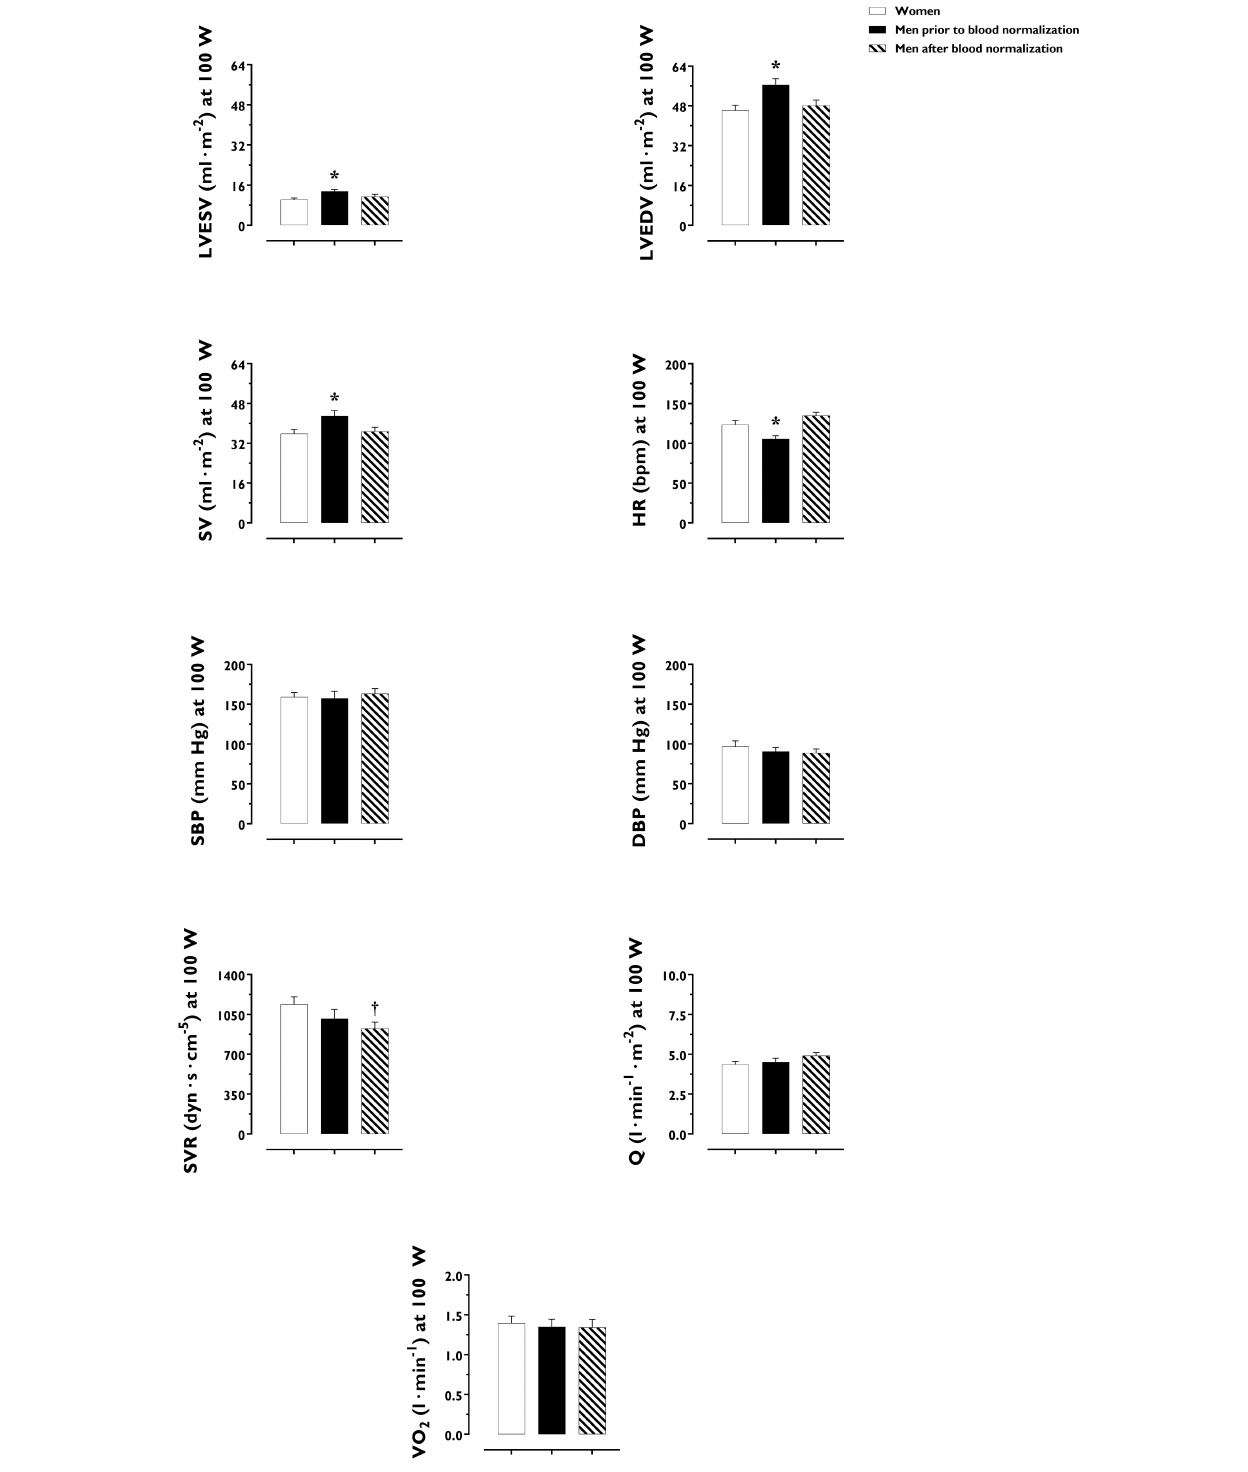
Frontiers in Physiology |